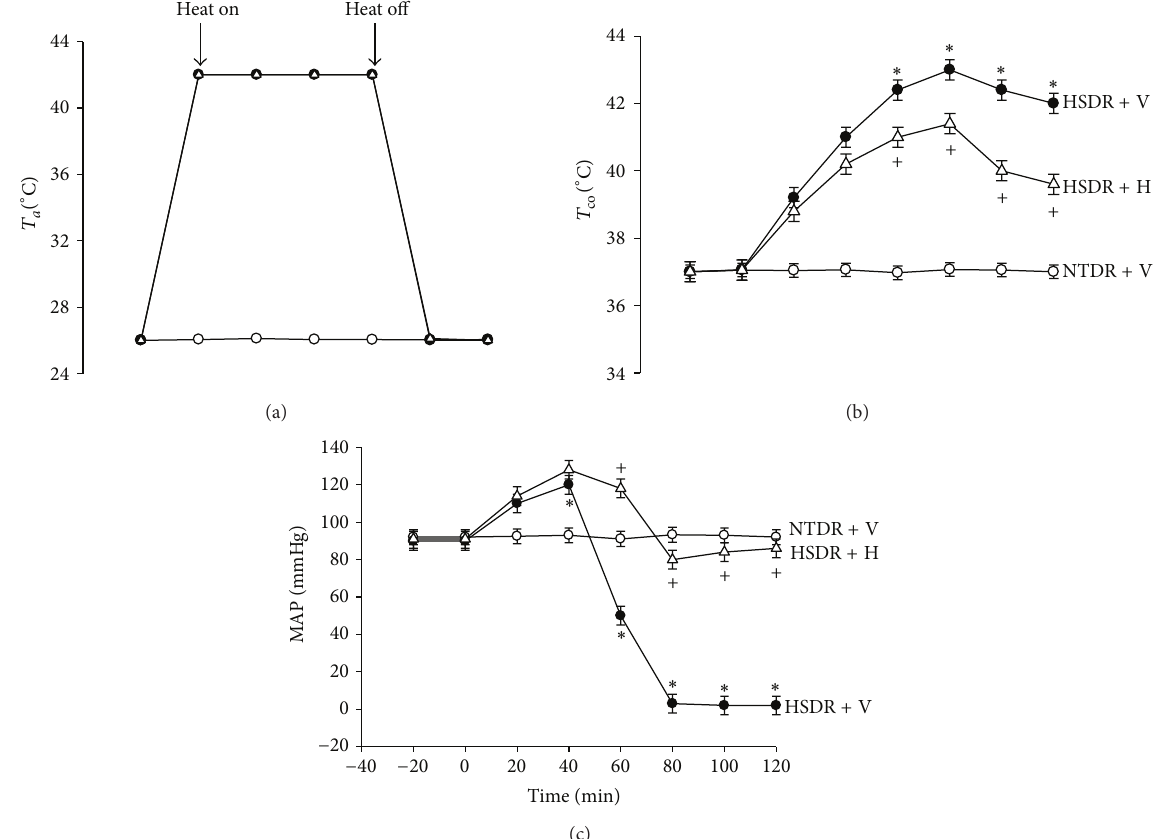
Figure 1: Values of both body core temperature ( 𝑇 co ) and mean arterial pressure (MAP) during different ambient temperatures ( 𝑇 𝑎 ) for normothermic diabetic rats treated with vehicle solution (NTDR + V; I ), heatstroke-diabetic rats treated with vehicle solution (HSDR + V; e ), and heatstroke-diabetic rats treated with honokiol (HSDR + H; △ ). Data were means ± standard deviation (SD) of eight animals per group. ∗ 𝑃 < 0.05 , in comparison with the ( I ) group; + 𝑃 < 0.05 , in comparison with the ( e )